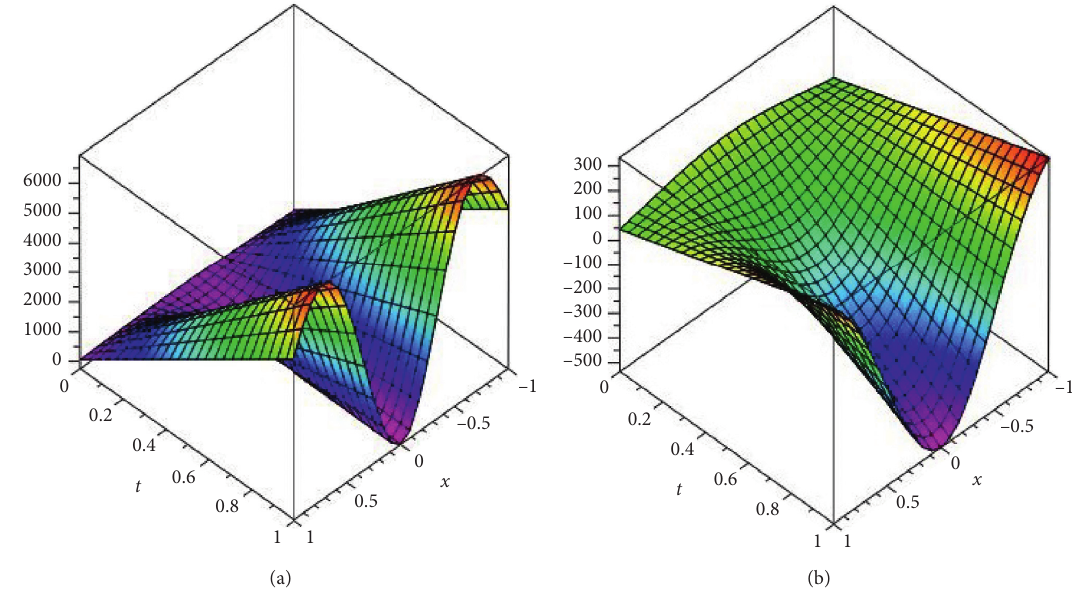
Figure 5: HPTM solutions of μ ( ζ , Ψ ) and ρ ( ζ , Ψ ) at c � 1.